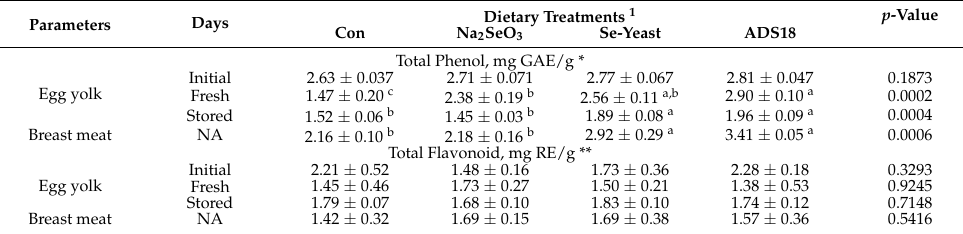
Table 4. Pre- and post-storage egg yolk and breast muscle 4 ± 2 ◦ C for 14 days.